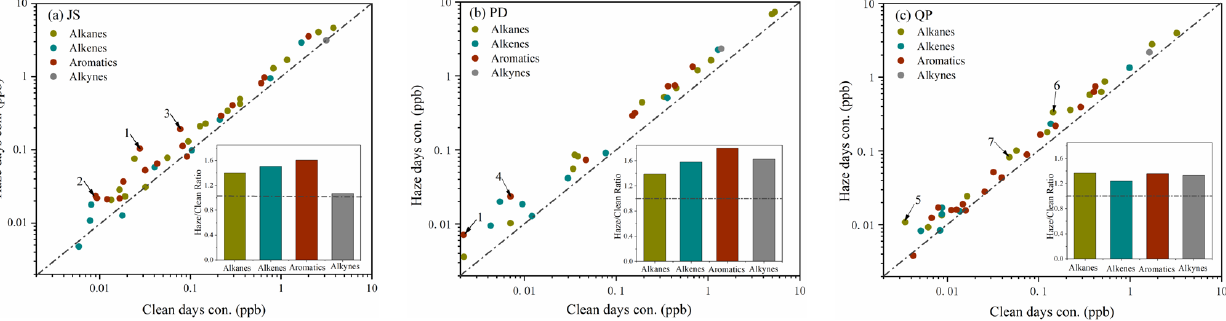
Figure 4. Differences in the VOC concentrations between the clean and haze days at the (a) JS, (b) PD and (c) QP sites. (1) 1, 2, 4- trimethylbenzene; (2) p -ethyltoluene; (3) m -ethyltoluene; (4) ethylbenzene; (5) 2, 2, 4-trimethylpentane; (6) n -hexane; (7) h